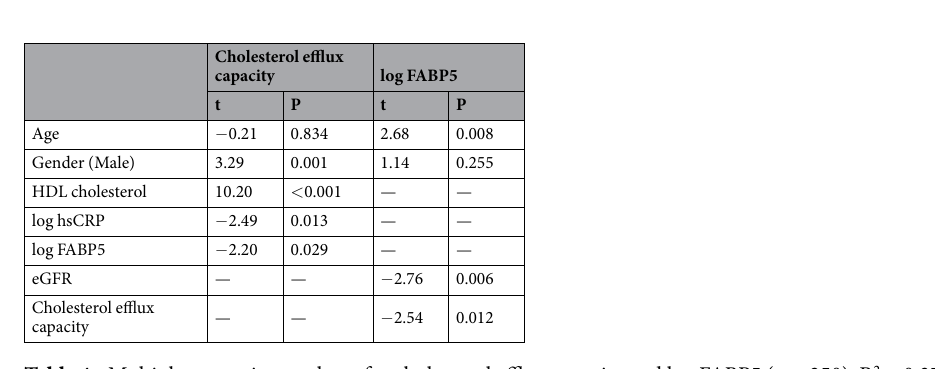
Table 4. Multiple regression analyses for cholesterol efflux capacity and log FABP5 (n = 250). R 2 = 0.378, AIC = 420.8 (for Cholesterol efflux capacity); R 2 = 0.157, AIC = 293.9 (for log FABP5). FABP5, fatty acid- binding protein 5; hsCRP, high-sensitivity C-reactive